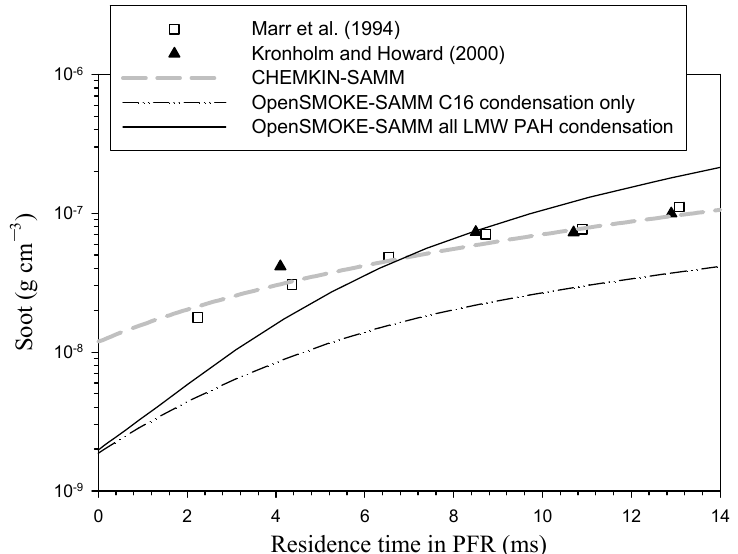
Figure 4. Comparison of soot mass concentrations predicted by CHEMKIN-SAMM and OpenSMOKE-SAMM with measured data [59,60].